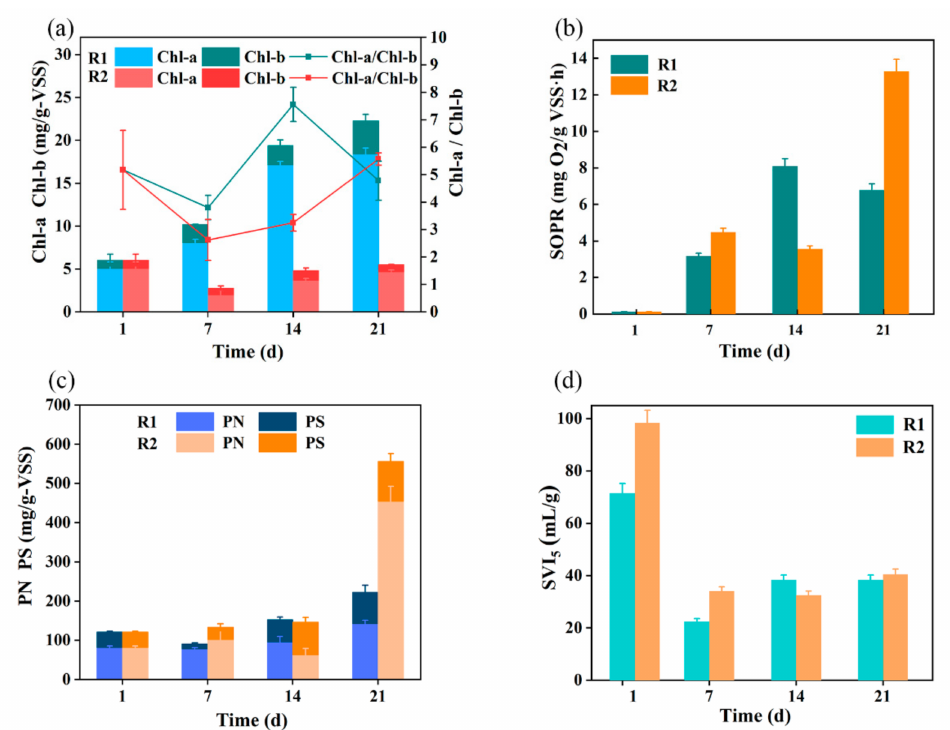
Figure 2. Variations in properties of microalgal-bacterial granular sludge during the reactivation process. ( a ) Chl-a, Chl-b, Chl-a/Chl-b; ( b ) SOPR; ( c ) PN, PS; ( d ) SVI 5 . (R1: Aeration; R2: Non-